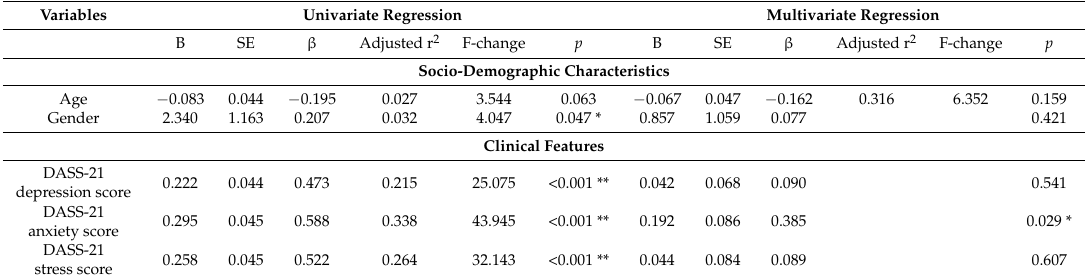
Table 3. Univariate and multivariate association between socio-demographics, clinical factors and